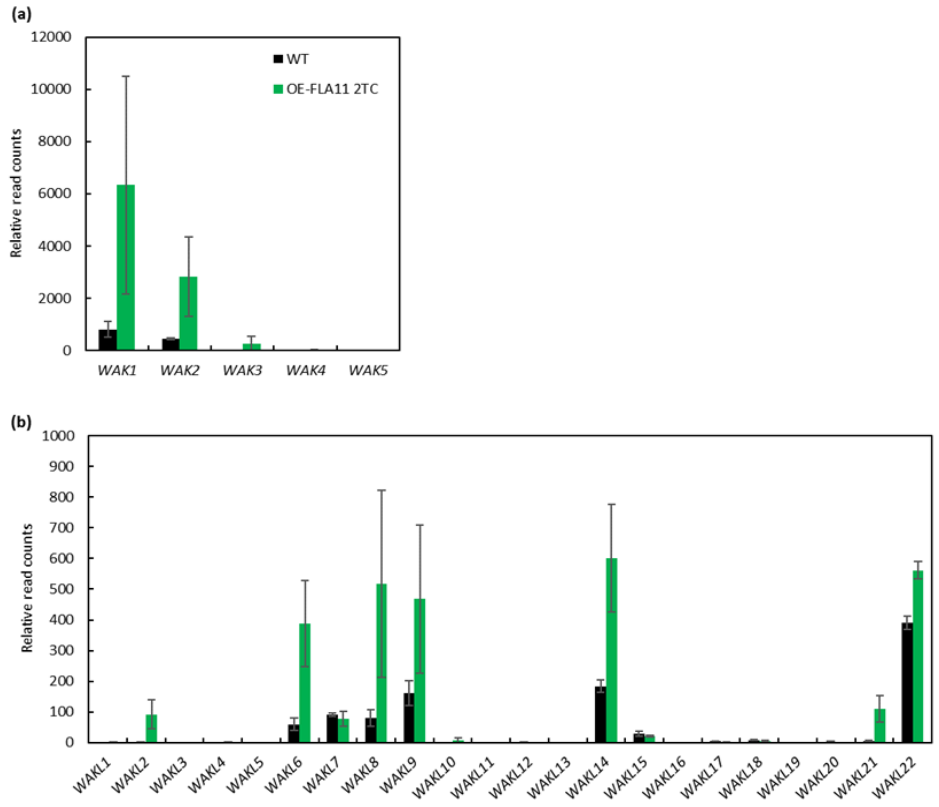
Figure 1. Comparison of WAKs/WAKLs transcript levels in OE-FLA11 and WT stems. Analysis of differentially expressed genes (DEGs) in OE-FLA11 stems compared with WT plants revealed upregulation of WAKs ( a ) and WAKLs ( b ) WAK1 , WAK2 , WAK3 , WAKL2 , WAKL6 , WAKL8 , WAKL9 , WAKL14 , WAKL21 , and WAKL22 , as shown by the relative read counts from RNA-seq.